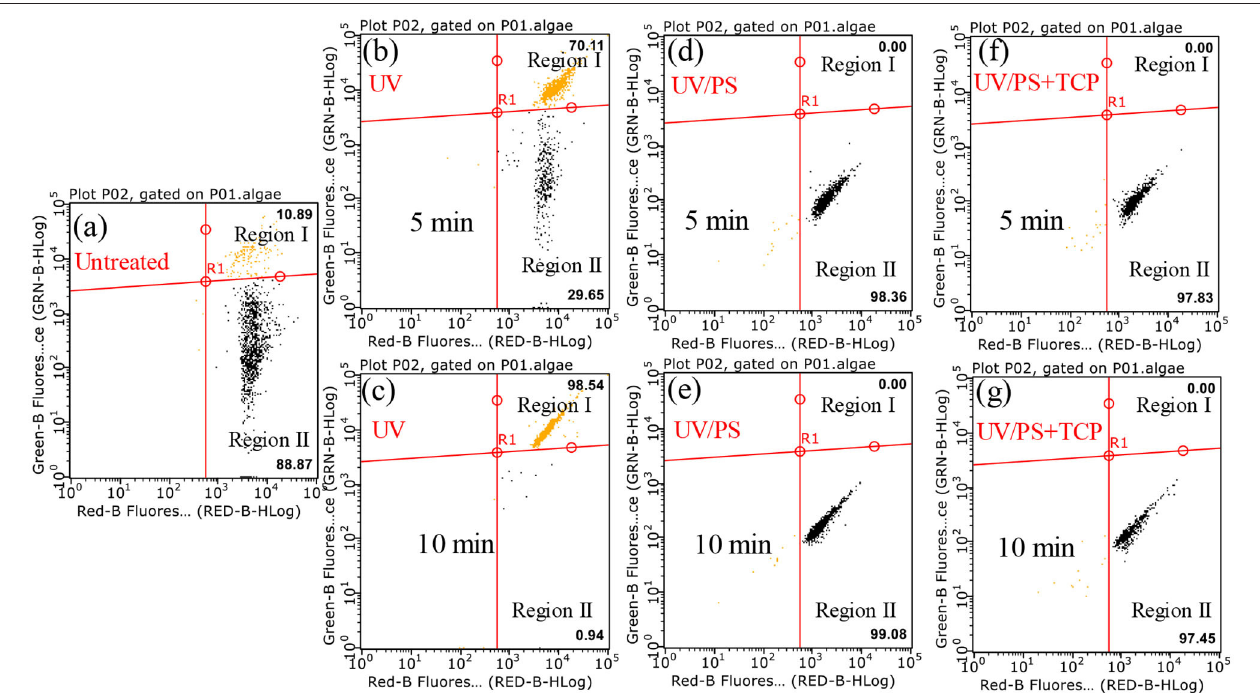
FIGURE 4 | Flow cytometry results after treatment by different processes. Conditions: initial algal cell density: (1.00 ± 0.05) × 10 6 cells/mL, initial TCP concentration: 0 µ M for (a–e) and 20 µ M for (f,g) , initial pH: 7.6 ± 0.2, temperature: 25 ± 1 ◦ C, UV intensity: 7.82 mW/cm 2 , PS dose: 1.5mM. The error bars represent the standard deviations from duplicate